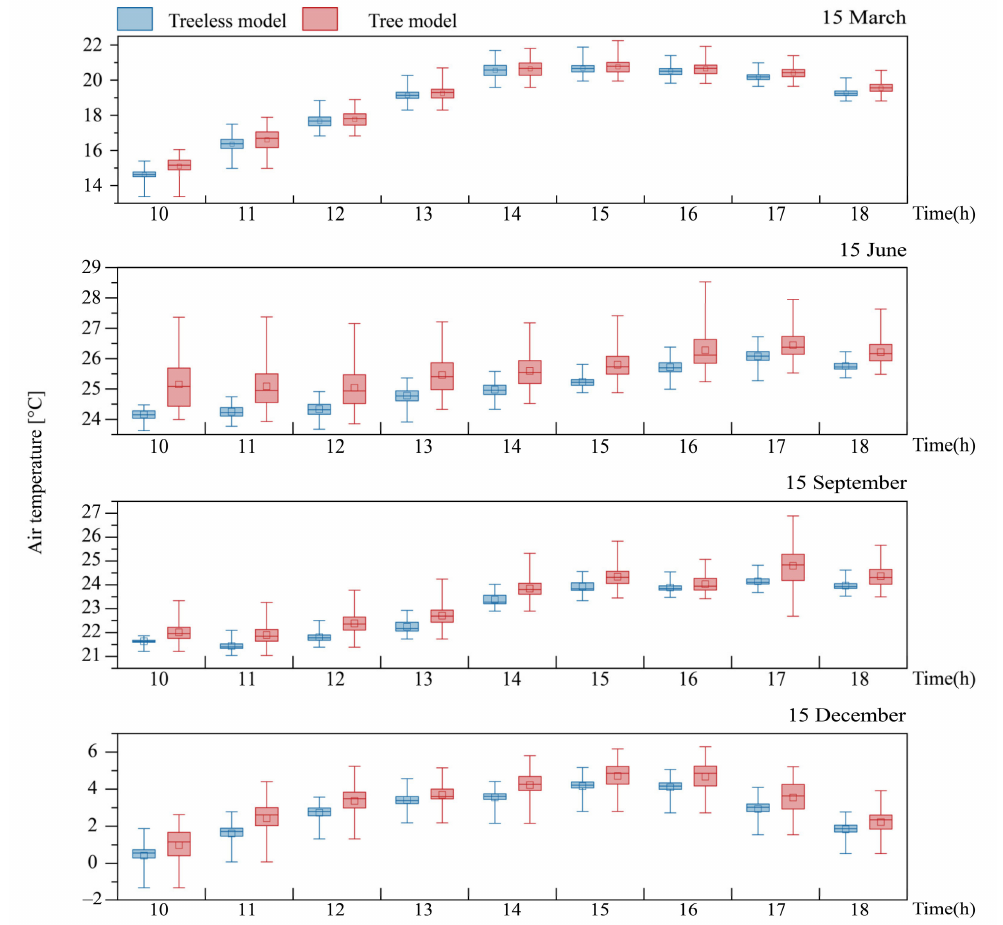
Figure 7. Comparison of the range of air temperature between two models at a height of 1.2 m on four